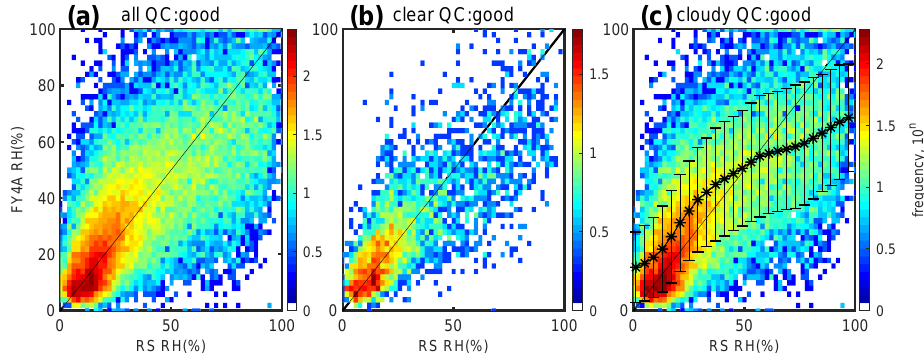
Figure 9. The 2D-histogram plot of FY4A humidity (y-axis) and radiosonde relative humidity (x-axis) under all-sky (sub-figure ( a )), clear sky (sub-figure ( b )) and cloudy sky (sub-figure ( c )). “all-sky” means the ensemble includes both clear sky and cloudy sky. The plots only contain the cases with quality flags of perfect or good. The color means the frequency of the observation, 10 n , n is the value in the color bars. All the observations are shown in this figure except the unreasonable cases in physics. ( a ): all cases are selected, with bias of 0.5%, uncertainty (RMS) of 20% and PCC of 0.6638; ( b ): cases under clear sky only, with bias of − 0.9%, uncertainty (RMS) of 18% and PCC of 0.7113; ( c ): cases under cloudy sky only, with bias of 0.8%, uncertainty (RMS) of 21% and PCC of 0.6552. The back star points are the average RH of FY4A. Standard error bar is also added to the means of FY4A. The cases in the vertical range from 280 hPa to the surface are selected in the plots. The straight lines are the one-by-one line. Star-line is the average line, and the standard error bars are also added to the start line. All the correlation coefficients are at 95% confidence level. The units are in the absolute value of %. The black line is the identity line.